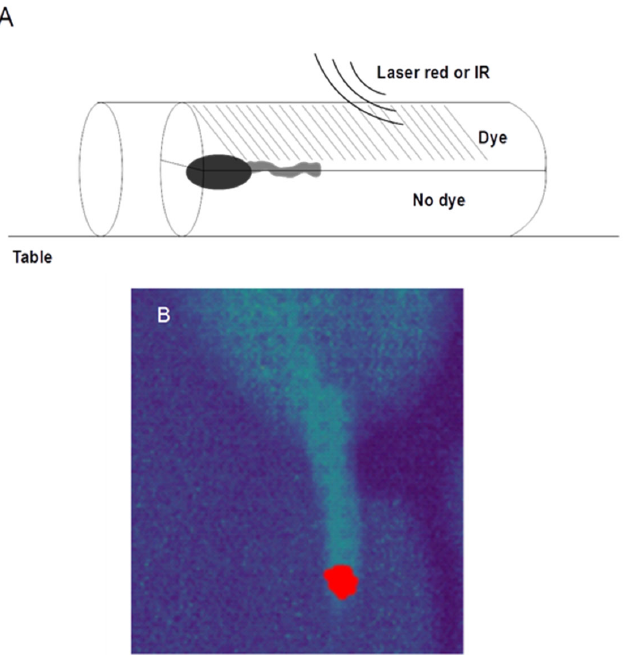
Figure 3. Experimental set-up used to study maize seedlings grown in agar. ( A ) The seedling was grown in a glass tube in between two layers of gel (with and without dye). Cameras were placed 90 ◦ over the sample on the table. ( B ) A total of 100 points (red) were randomly collected at the tip of the root using a Gaussian distribution.